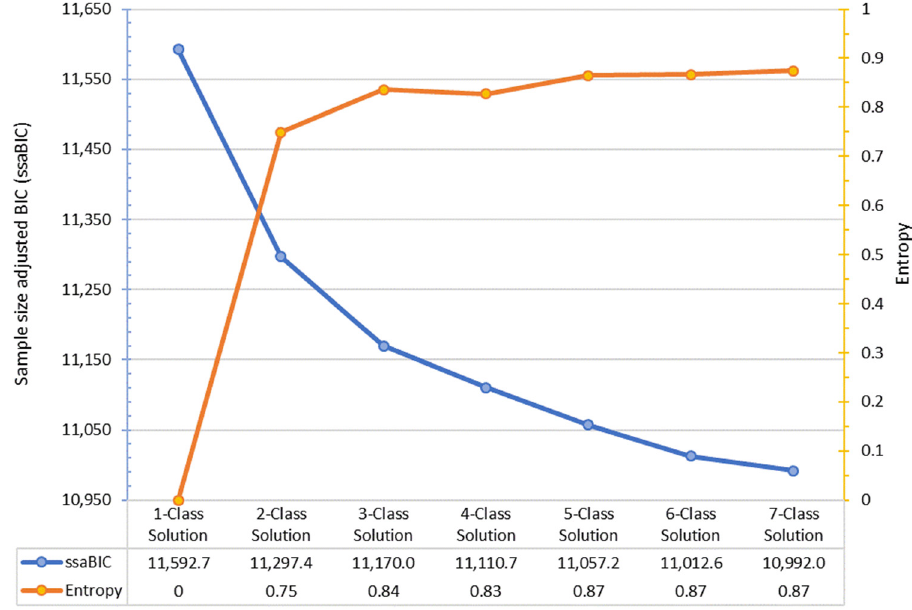
Figure 1. Model fit information criteria of latent classes compared for analysis.